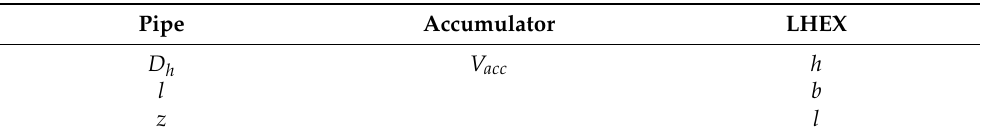
Table 2. Summary of the parameters that are exchanged in the application examples. The pipe parameters D h and z represent the pipe hydraulic diameter and its lumped pressure loss coefficient. The pressure loss coefficient is a result of pipe bends and contractions/expansions. The parameter l represents pipe or LHEX length. The LHEX height and width are denoted h and b and the accumulator volume V acc